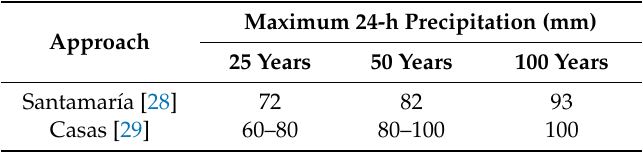
Table 2. Soil physical and chemical properties of the experimental site at different depths.